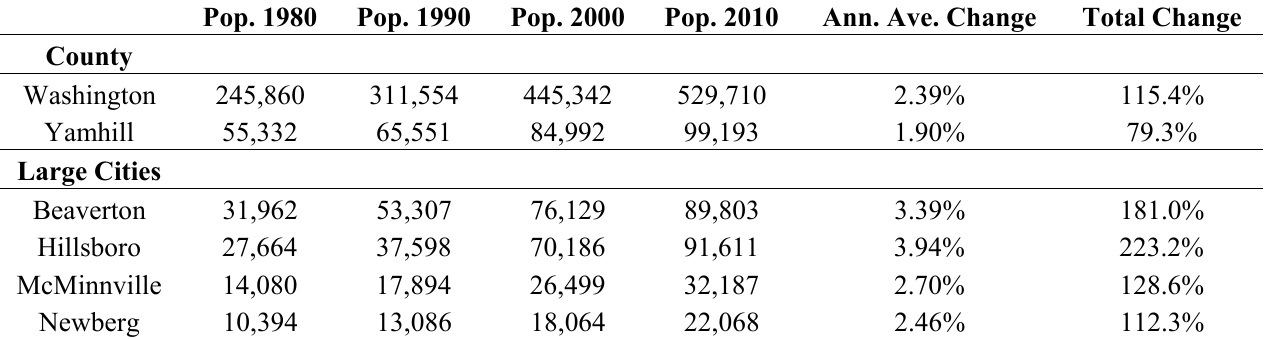
Table 1. Populations by decade for two counties and select cities in the study